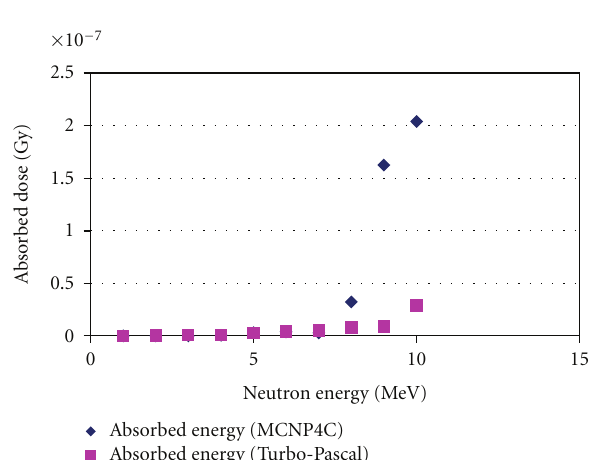
Figure 10: The absorbed dose in the collimator.